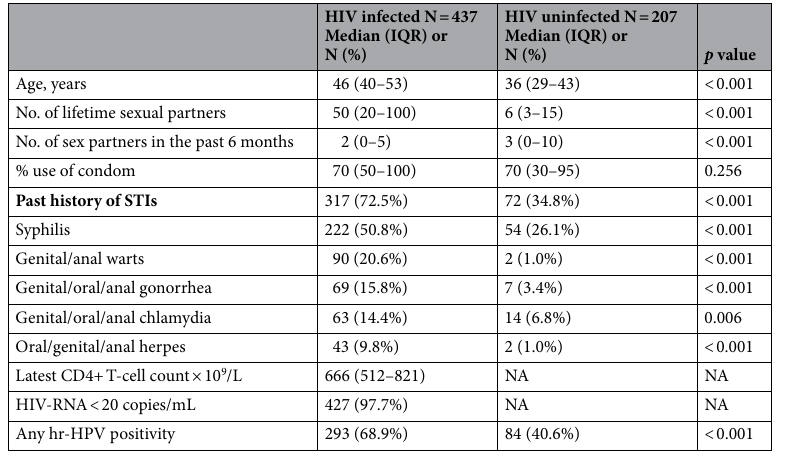
Table 1. Demographic characteristics of HIV-infected and -uninfected Japanese MSM. The denominator for hr-HPV positivity is 425. MSM men who have sex with men, STIs sexually transmitted infections, IQR interquartile range, hr-HPV high-risk types of human papillomavirus, UD undetectable.